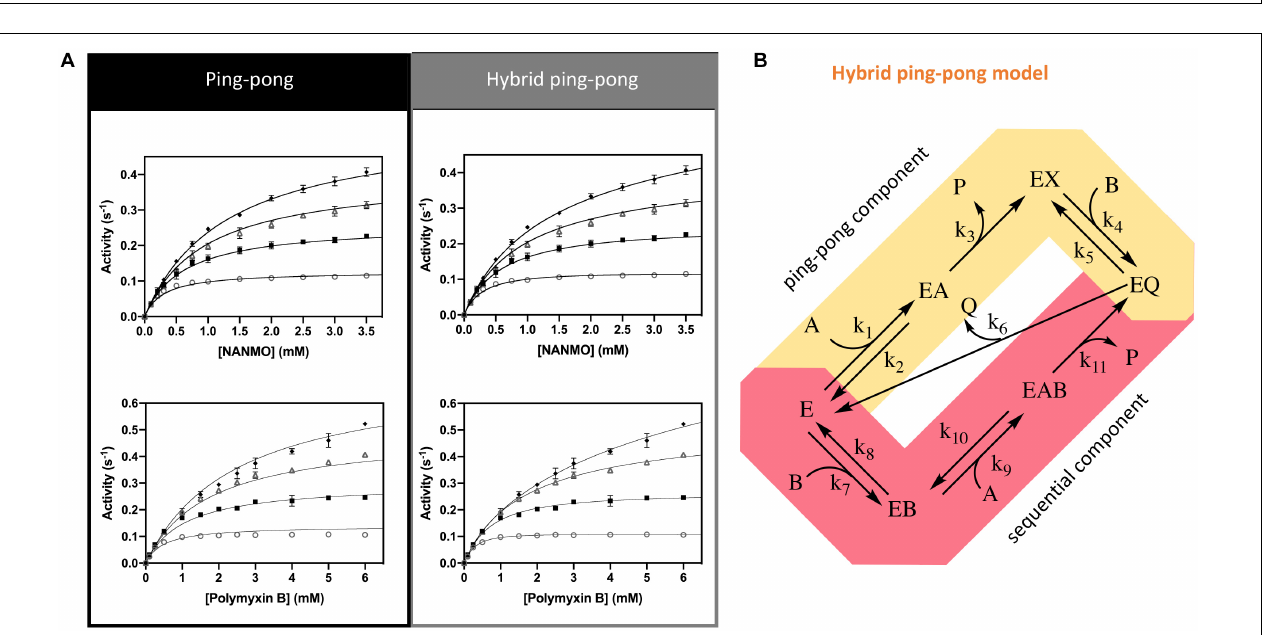
FIGURE 5 | Conserved residues of homologs mapped onto the PA3944 WT structure (PDB ID: 6EDV). (A) Conserved residues of all 11 homologs identified by DALI mapped onto the PA3944 WT structure. (B) Conserved residues of top four homologs (PDB IDs: 3FBU, 2FSR, 2ZW7, and 3JUW) mapped onto the PA3944 WT structure. Residues are colored in a step gradient from gray (no to low conservation) to red (high conservation) and CoA is present in the acyl donor site of the PA3944 structure. Key residues in the donor and acceptor sites are shown in sticks. (C) Linear sequence comparison of top 4 homologs and PA3944 colored by conservation. (D) Rotated view of PA3944 with acceptor site indicated and all red (completely conserved) residues and CoA shown as sticks. The majority of the conserved residues are found in the donor site or near the catalytic center where the acyl donor site and acceptor sites join.